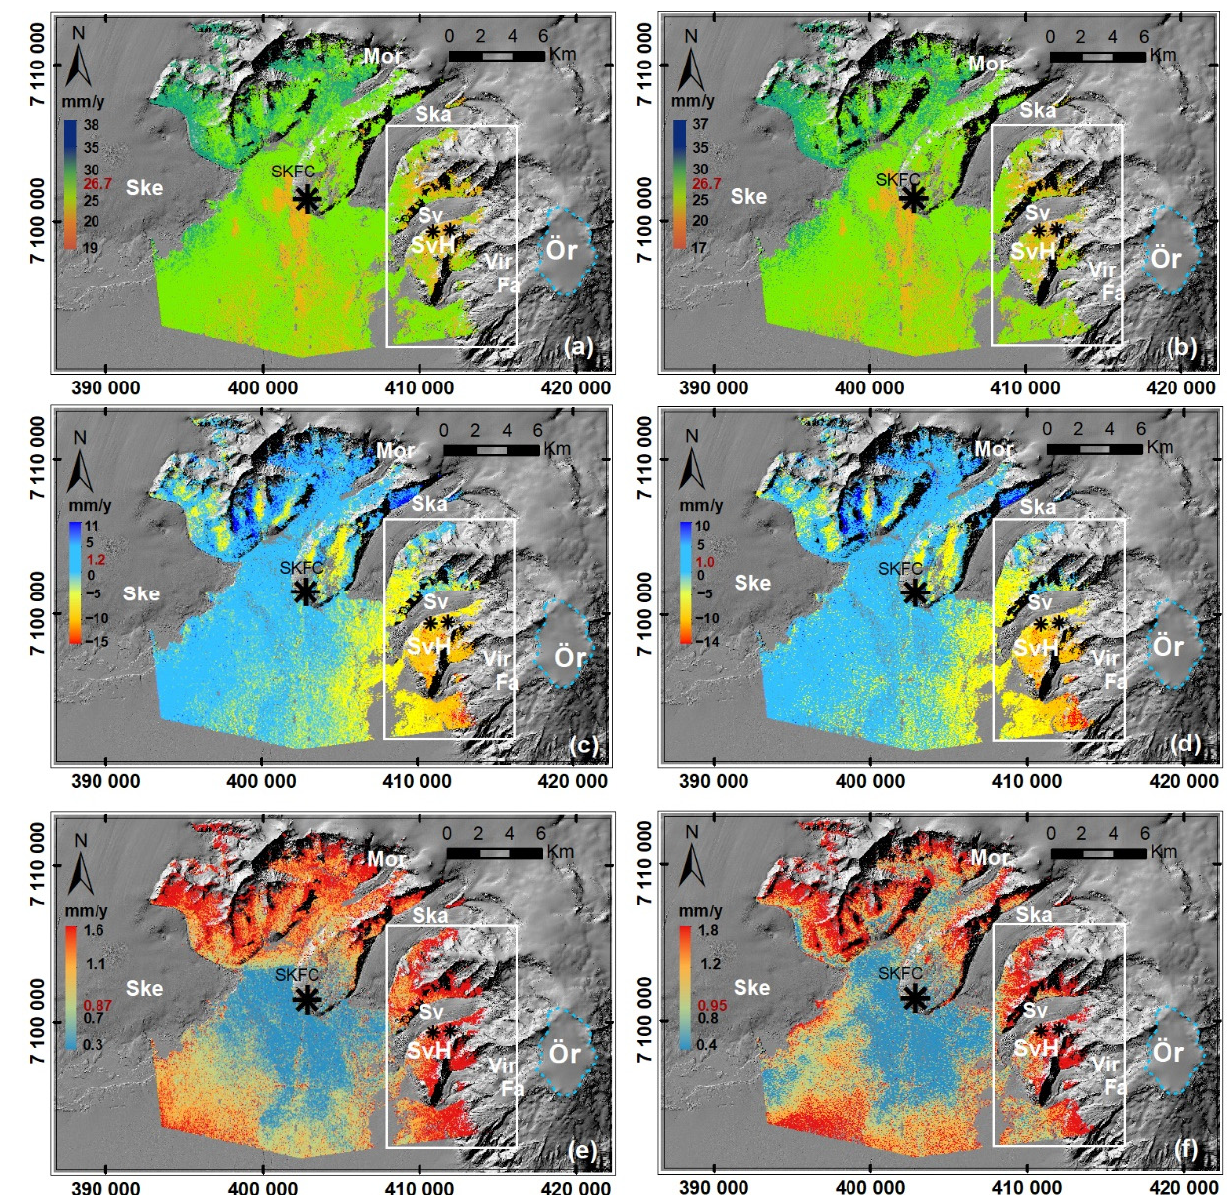
Figure 7. Decomposed deformation velocities in 2D: The left panel shows results from A2D decom- position, and the right panel shows results from D2A decomposition. ( a , b ) show the decomposed vertical velocities V v ; ( c , d ) illustrate the decomposed horizontal velocities V h ; and ( e , f ) show the range of the std . V los of the QPSs selected for the 2D decomposition from the ascending and de- scending data, respectively. Note that the maximum std . V los values of QPSs from A and D data decrease considerably (cf. Figure 5c,d), subjected to the removal of strongly nonlinear deforming PSs (high 𝑠𝑡𝑑. 𝑉 (cid:3039)(cid:3042)(cid:3046) ) during the thresholding. Numbers in red for all colour scales indicate the median value of the presented parameter. White boxes in ( a – f ) indicate terrain slopes under primary inves- tigation. Abbreviations of major outlet glaciers and slope are presented in white from left to right: Ske—Skeiðarárjökull; Mor—Morsárjökull; Ska—Skaftafellsjökull; Sv—Svínafellsjökull; SvH— Svínafellsheiði slope; Vir—Virkisjökull; and Fa—Falljökull. Öræfajökull (Ör) central volcano is cir- cledby blue-dashed line.